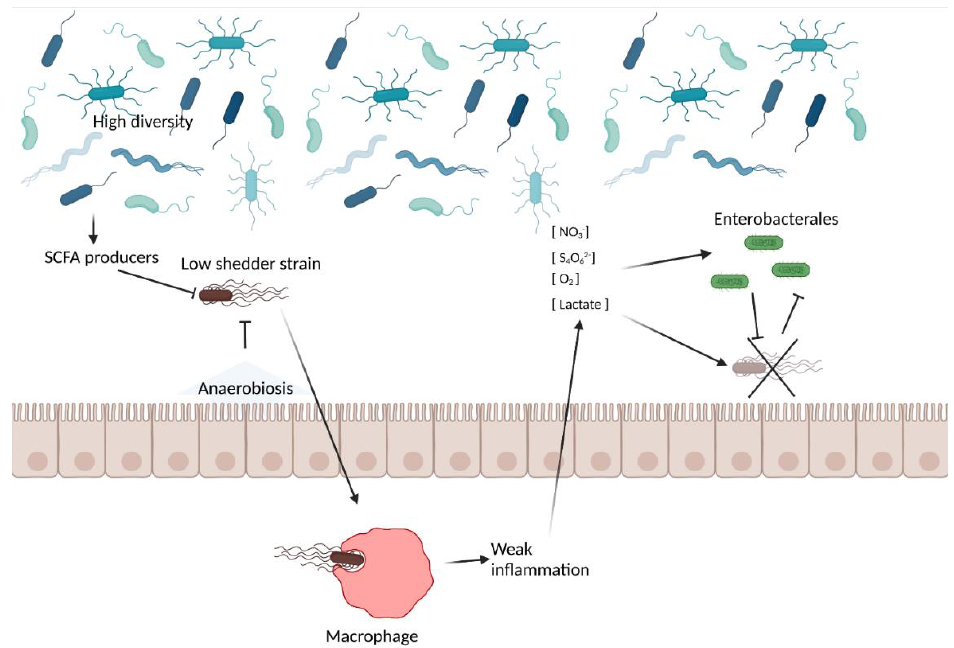
Figure 2. Possible mechanisms at play in the low shedder phenotype. A gut with a high diversity and a high microbiota-nourishing immunity, via the presence of bacteria conferring a strong barrier effect, such SCFA producers, that promote epithelial anaerobiosis, may prevent the installation of the pathogen. This may be exacerbated by the lack of intrinsic virulence factors, i.e., if the pathogenic strain itself is more prone to generate a low shedder phenotype. If the pathogen succeeds in eliciting an inflammatory response required to create a new niche for pathogen installation, it may outcompete the resident gut microbiota in strong competition with closely related microbial bacteria (e.g., Enterobacterales in the case of Salmonella and E. coli O157:H7), which may prevent its luminal expansion. Created with BioRender.com, accessed on 18 October